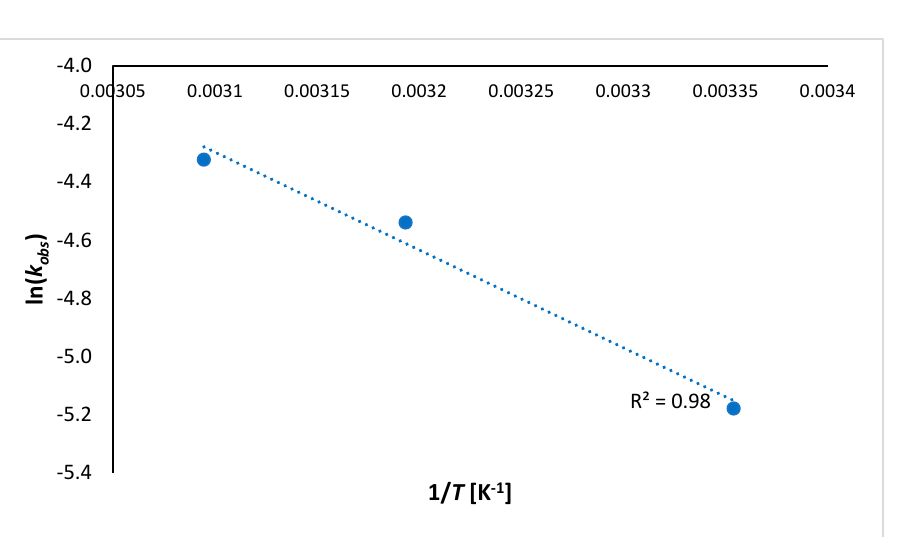
Figure 4. Arrhenius plot obtained using the experiments conducted at different temperatures.